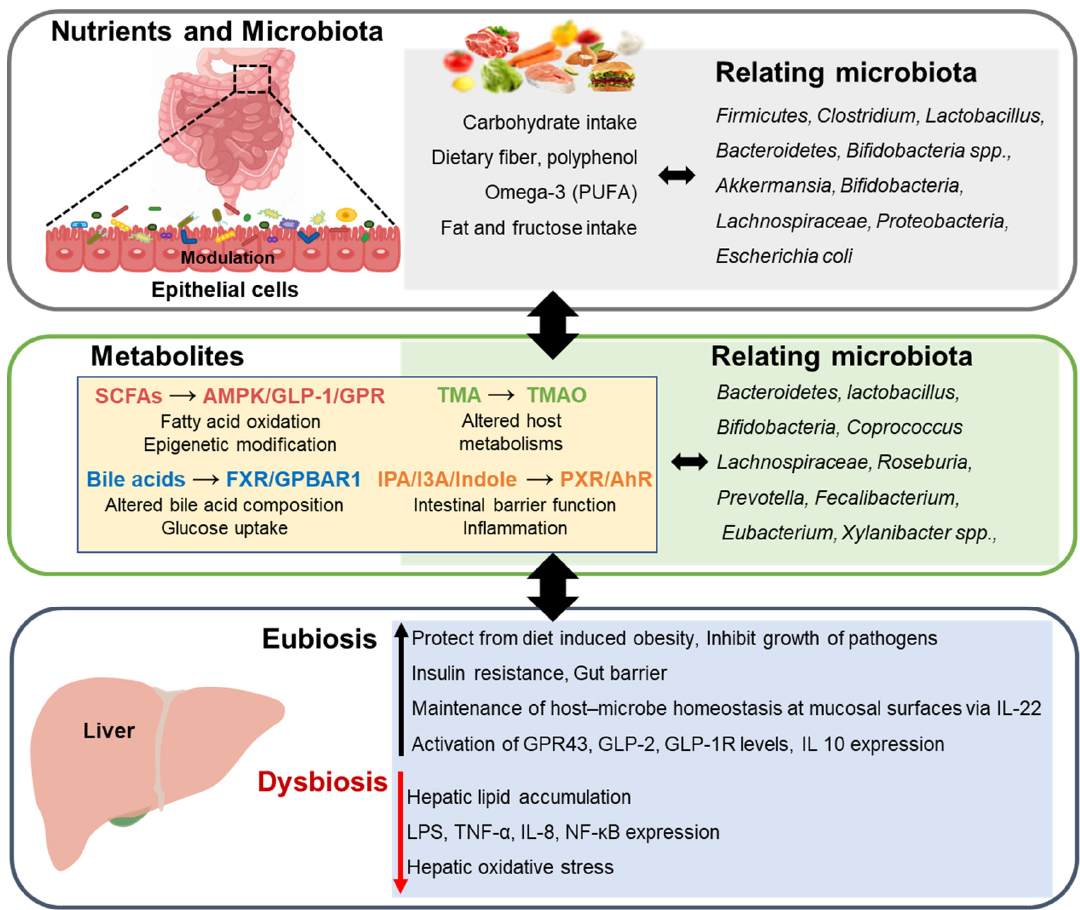
Figure 1. Interaction between nutrition and gut microbiome in the progression of chronic liver disease. SCFAs, short-chain fatty acids; GPR43, G-protein-coupled receptor 43; GLP, glucagon-like peptide; LPS, lipopolysaccharide; IL-10, interleukin-10; IL-22, interleukin-22; NF- κ B, nuclear factor kappa- light-chain-enhancer of activated B cells; TNF, tumor necrosis factor; TMA, trimethylamine; TMAO, trimethylamine-N-oxide; IPA, indole-3-propionic acid; I3A, indole-3-acetic acid; PXR, pregnane X receptor; AhR, aryl hydrocarbon receptor; AMPK, AMP-activated protein kinase; GLP-1,